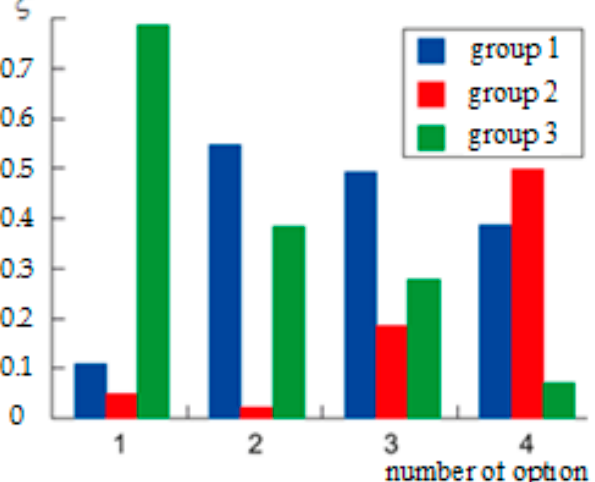
Figure 13. Distribution of workable CTS samples by degradation levels at different values of parameters determining the rate of degradation.